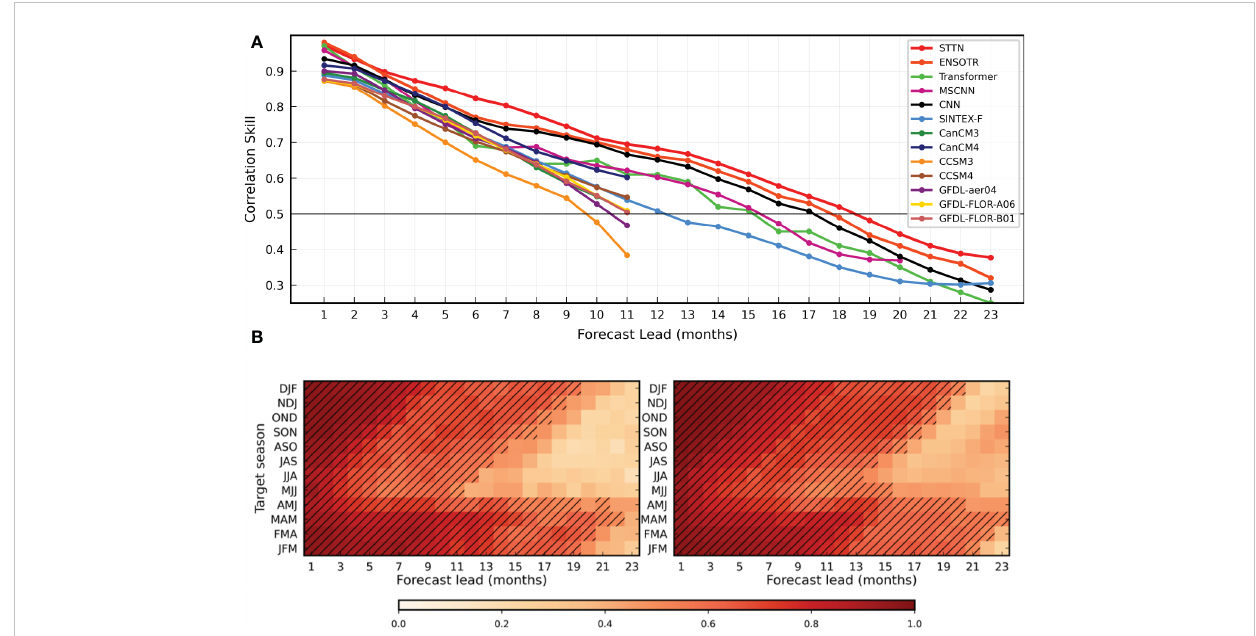
FIGURE 3 ENSO predicts all-season Temporal Anomaly Correlation Coef fi cient Skill (ACorr) in the STTN model. (A) The ACorr of the three-month-moving- averaged Nino3.4 index with Several lead times from ˜ 1982 to 2017 in the STTN model(red), Convolutional Neural Network (CNN) model (black), parallel deep CNNs with heterogeneous Architectures MS-CNN(Light purple), ENSO transformer(ENSOTR)(Orange color), Transformer(Lemon- green), Scale Interaction Experiment-Frontier dynamical prediction system (Sky blue), including additional dynamic prediction systems in the North American Multi-Modal Ensemble (NMME) project (other colors). The ACorr of the Nino3.4 index of every season in the ensemble CNN ˜ model (B.left) and the STTN model (B.right). The light black line indicates that ACorr is equal as 0.5.